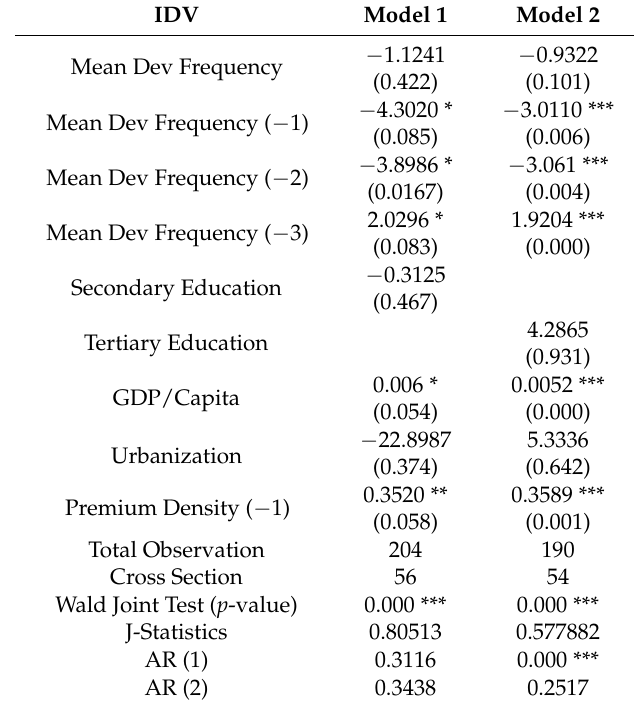
Table 2. Determinant of PCI with frequency of extreme events as memory cues: panel data results